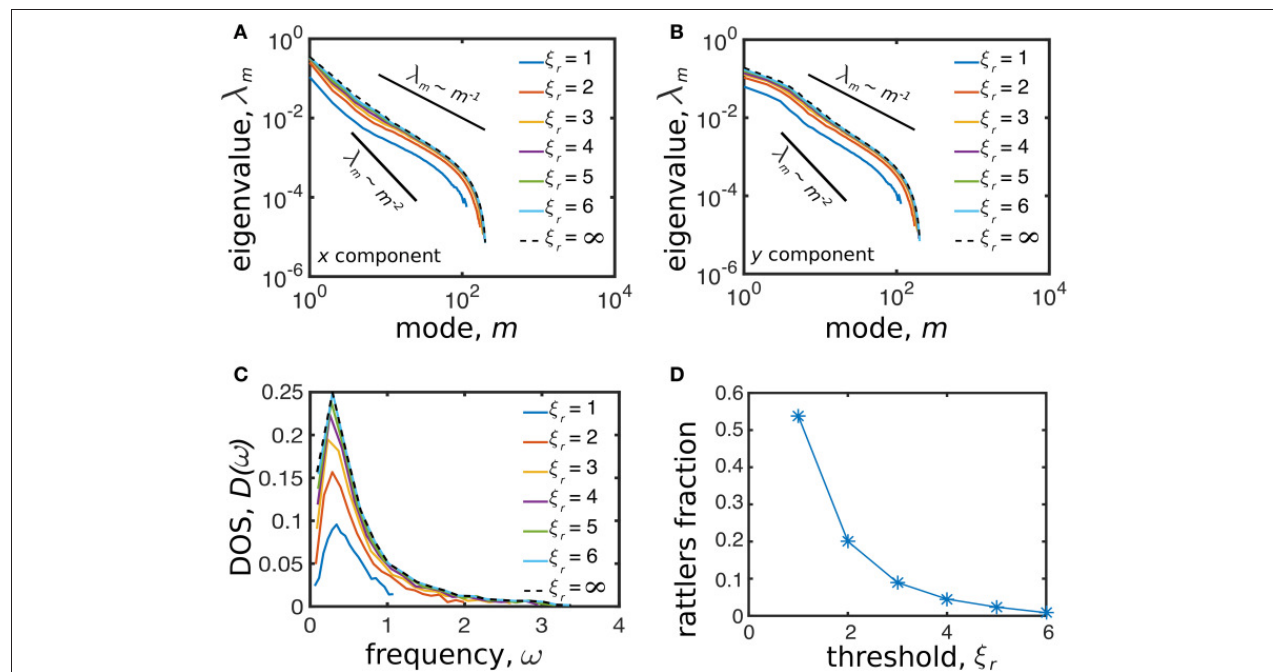
FIGURE 4 | The eigenvalue spectrum of the displacement correlation matrix before removing the rattlers (dashed black line, threshold for removal is infinitely large) and after removing the rattlers using different values of the threshold ξ r (solid colored lines, threshold for removal is finite) for the (A) x and (B) y components. (C) The basic shape of the DOS is conserved for different values of the threshold ξ r . (D) The fraction of rattlers monotonically decreases as the threshold value ξ r increases.